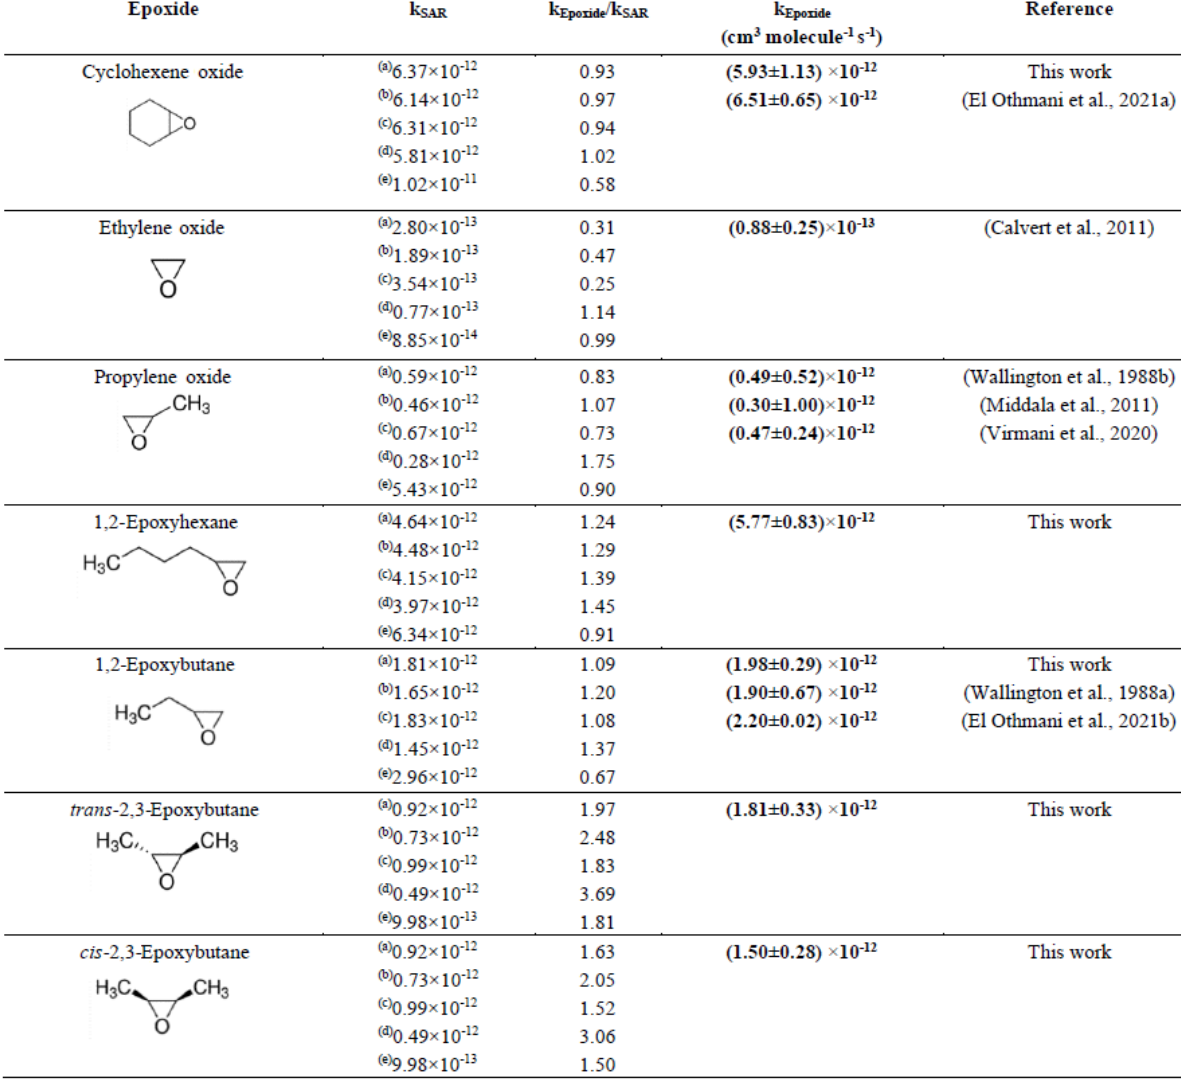
Table 3. Comparison of the rate coefficients for the reaction of OH radicals with the epoxides investigated in this study with the literature data and SAR predictions k Epoxide /k SAR